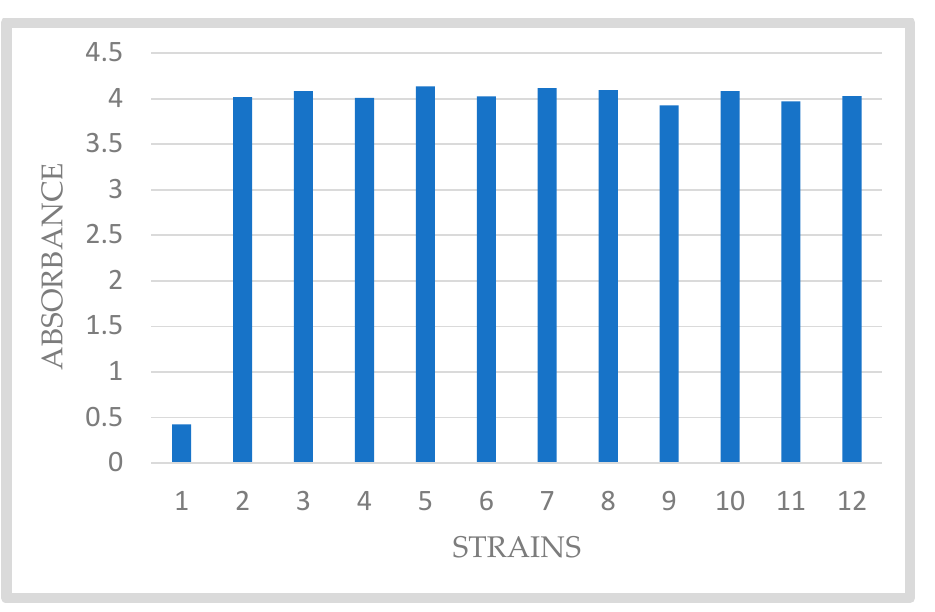
forming strain, 2—reference strain S. mutans UA159, 3–7—clinical isolates from adults, 7–12—clinical 12—clinical isolates from children. Bars represent mean values ± standard deviation. isolates from children. Bars represent mean values ± standard